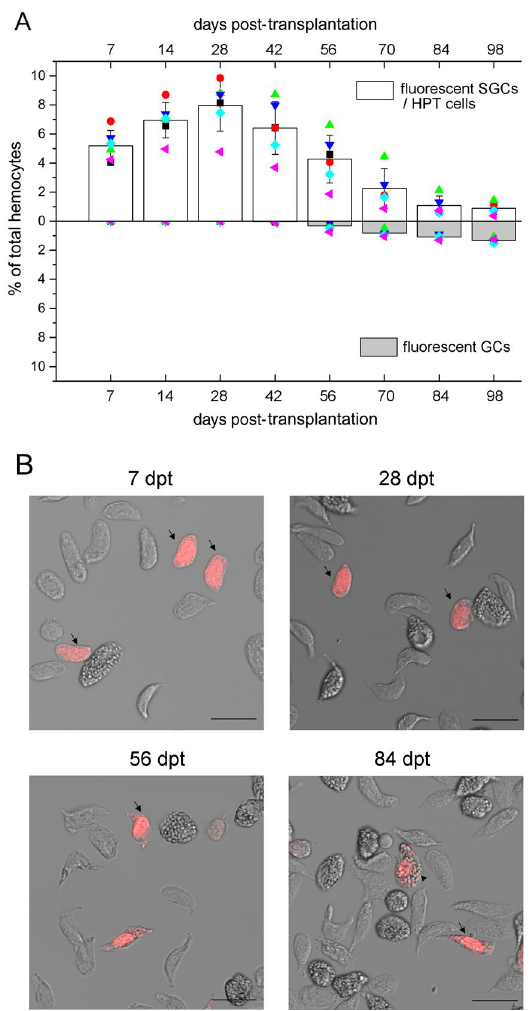
Figure 3. Approximately 60% of transplanted HPT cells develop into GCs. HPT cells were isolated from the donor animals, labeled with a nontoxic fluorescence cell tracer (red) and transplanted into the recipients. Hemocytes were taken from the recipients and analyzed at different time points. The percentages of fluorescent GCs and SGCs/HPT cells in the total hemocytes were determined by flow cytometry and fluorescence microscopy. Over 10,000 cells were analyzed for each sample ( A ). Five animals were used in each group. Data from different individuals are indicated by different symbols. Images of transplanted cells (red) in the samples collected at various time points are shown ( B ). Fluorescent SGCs/HPT cells are indicated with arrows, and fluorescent GCs are indicated with arrowheads. Bar, 25